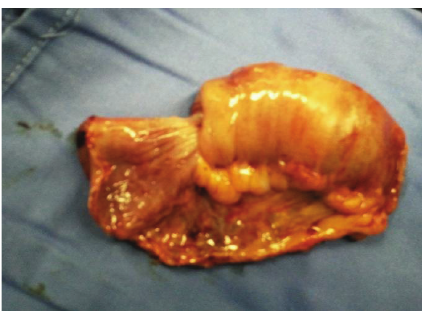
Figure 3: Jejunal tumor (GIST) was the leading point of intussus-